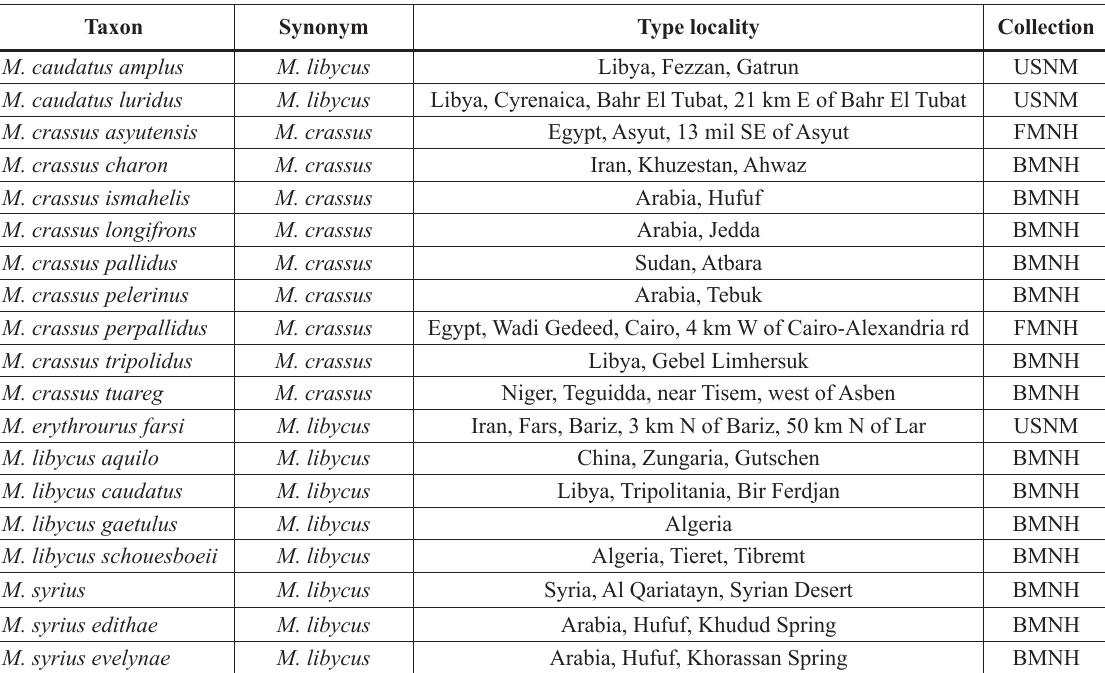
Table 1. List of type specimens included in this study. Synonyms are according to Musser & Carleton